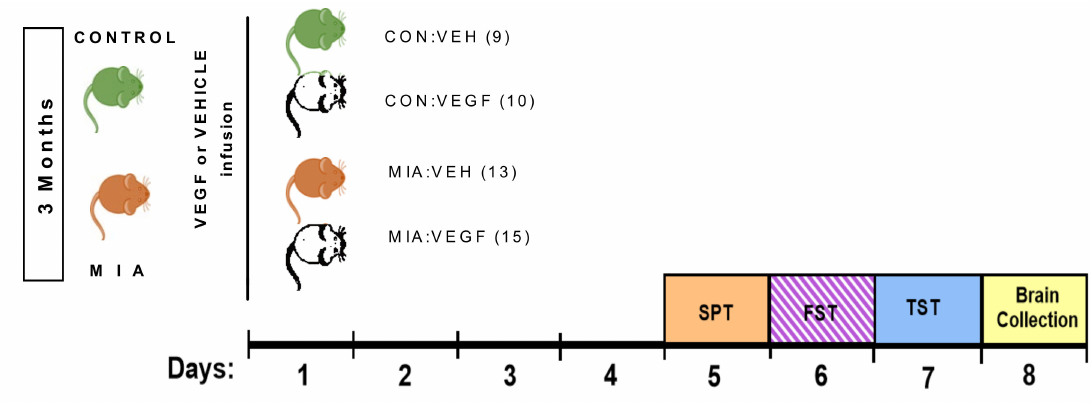
Figure 1. Schematic overview of the experimental design. MIA: maternal immune activation; VEH: vehicle; VEGF: vascular endothelial growth factor; SPT: sucrose preference test; FST: forced swim test; TST: tail-suspension test. Numbers in parentheses indicate the number of animals used in each